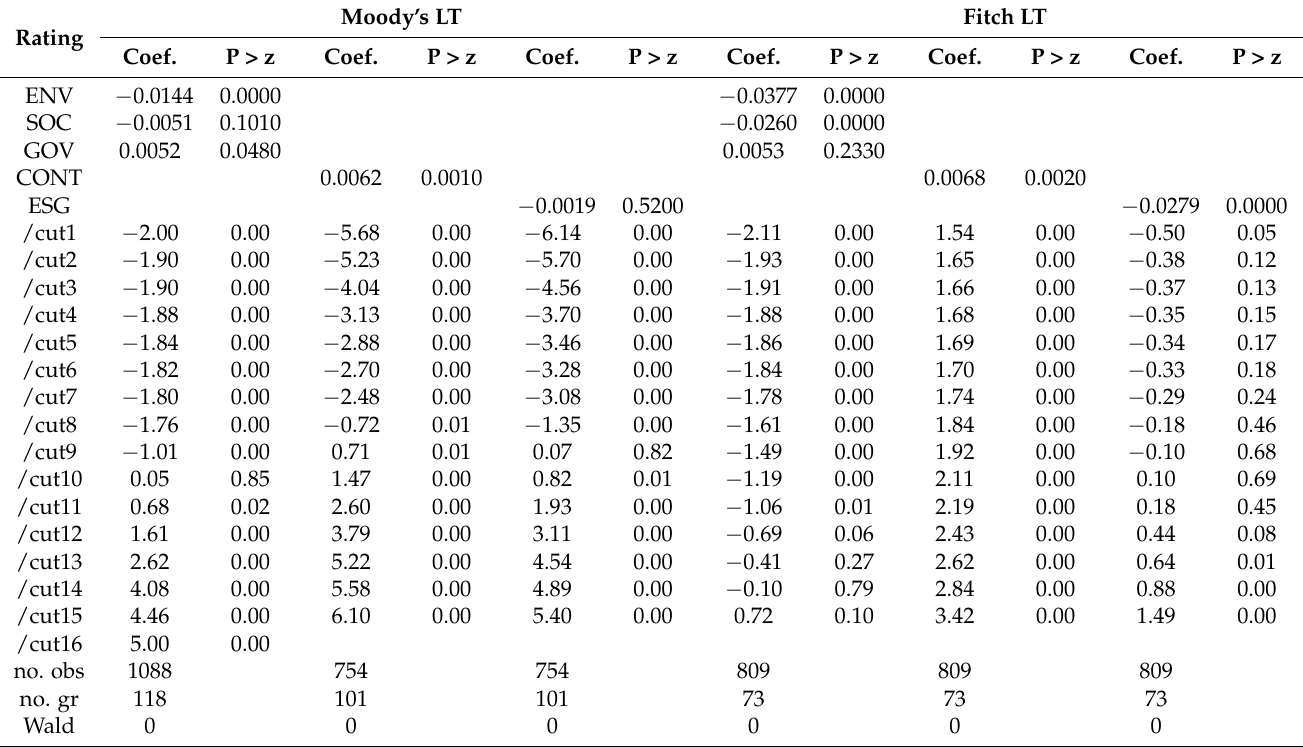
Table 6. Impact of ESG measures on Moody’s long-term issuer credit ratings and Fitch long-term issuer credit ratings. Moody’s Rating